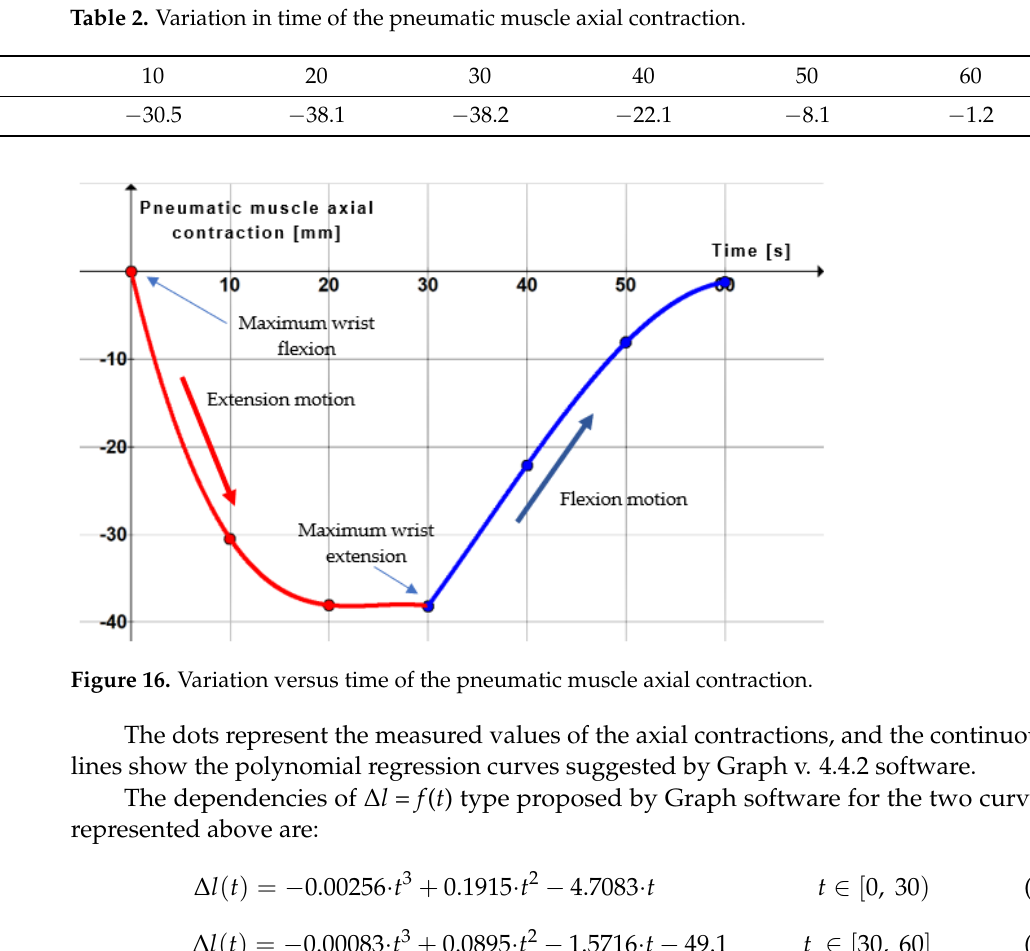
ynomial regression curves proposed by Graph software.